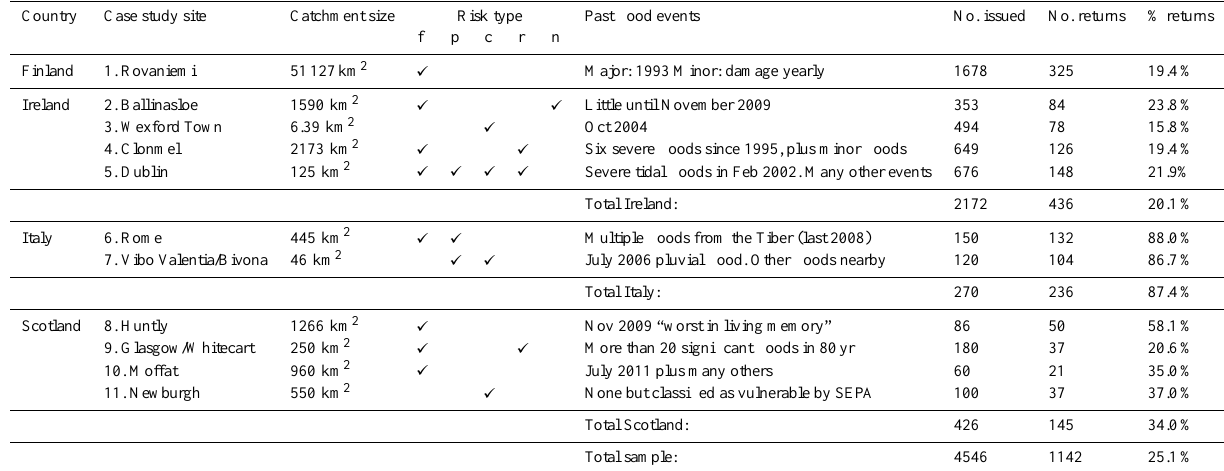
Table 1. Case study sites, risk types (f=fluvial, p=pluvial, c=coastal, r=residual and n=new), flood history and questionnaire dissemination